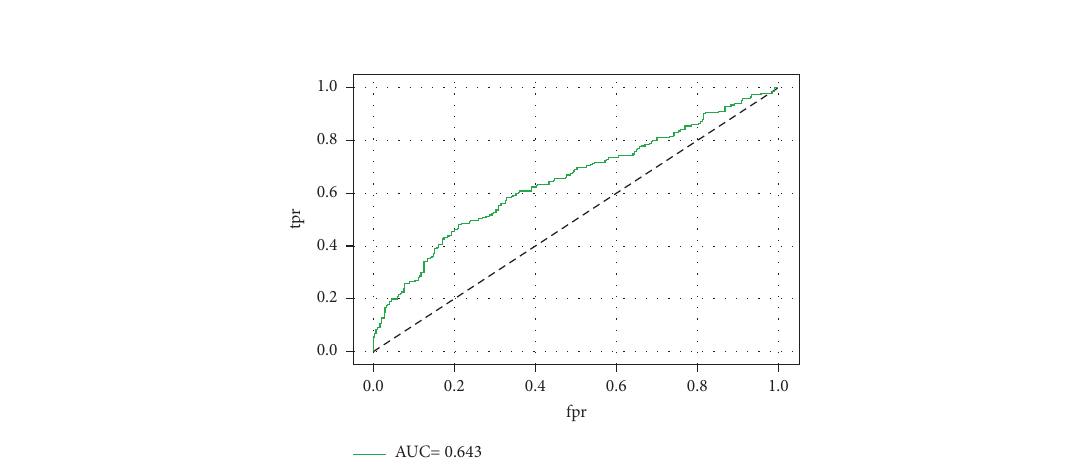
Figure 10: The high precision data set model is applied to the low precision data set. Table 9: Results of the updated high precision data set